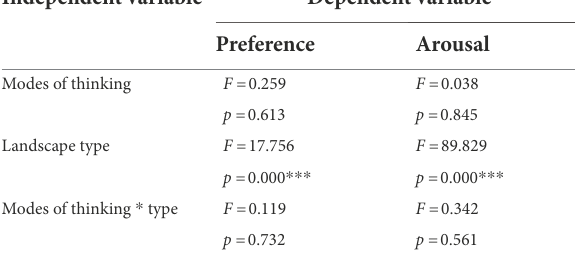
TABLE 4 Two-factor repeated measures analysis of variance for self-